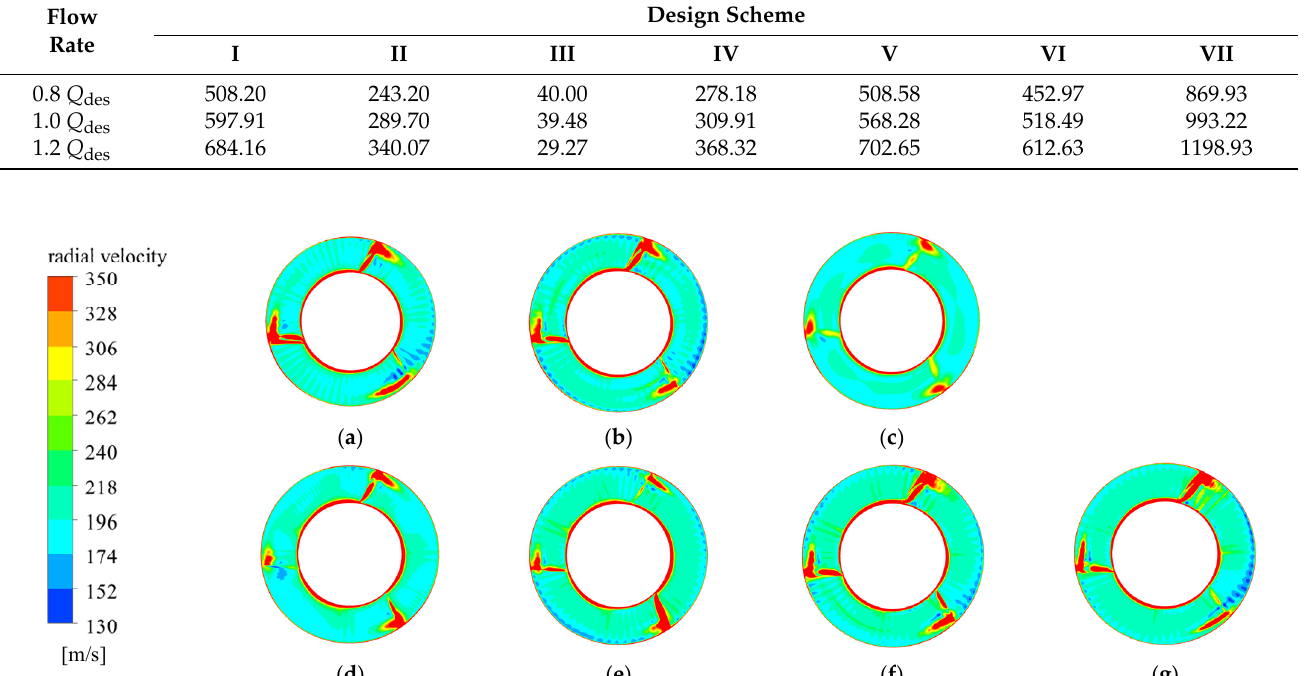
Table 7. Average radial forces.